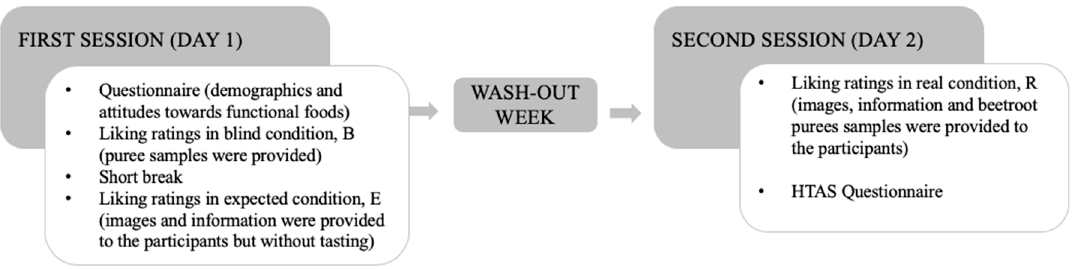
Figure 1. Schematic timeline of the study procedure.